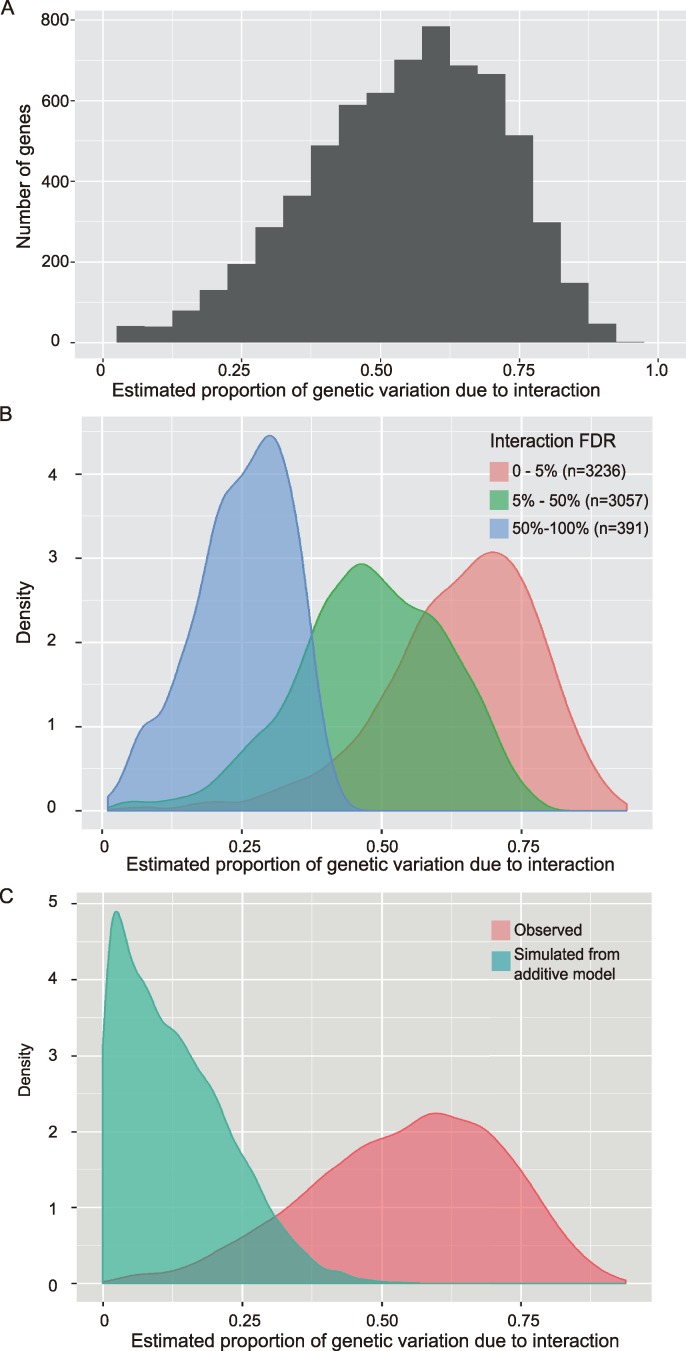
Contribution of epistasis to the genetic regulation of hepatic gene expression.Diagrams representing the estimated proportion of genetic variation due to interactions for (A) all genes expressed in the mouse liver whose expression was under genetic control in the CSS strains studied, (B) the same data segregated based on the statistical evidence supporting an effect of interaction on gene expression, and (C) a comparison of the genes with the most significant evidence for regulation by genetic interactions (FDR < 0.05) and a simulation study with artificial data that model the absence of any genetic interactions.